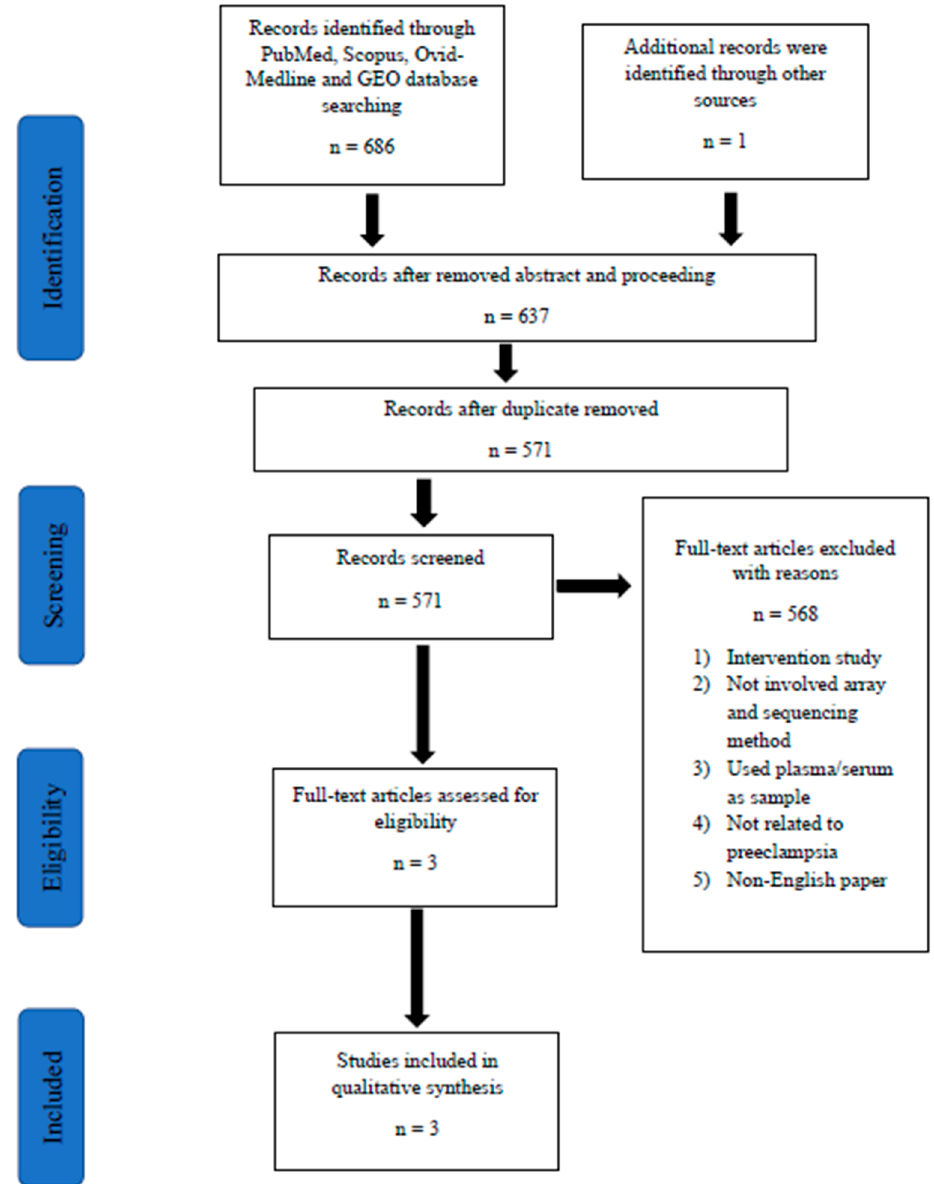
Figure 1. The algorithm for selection of studies in this systematic review. Abbreviation: GEO, Gene Expression Omnibus.